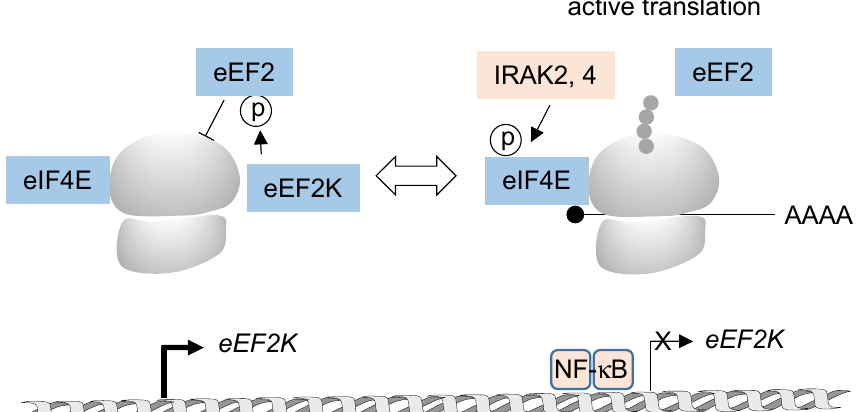
Figure 4. The impact of NF- κ B-mediated gene expression and IRAK2/IRAK4 function on protein translation, the ribosomes and the nascent peptide chain are schematically depicted.